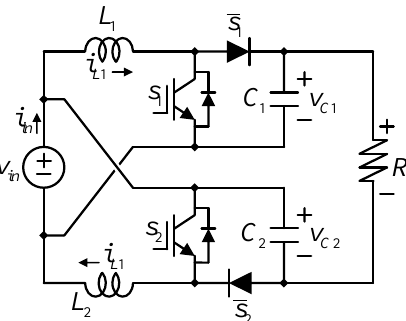
Figure 2. The topology of a double dual boost converter (DDBC).